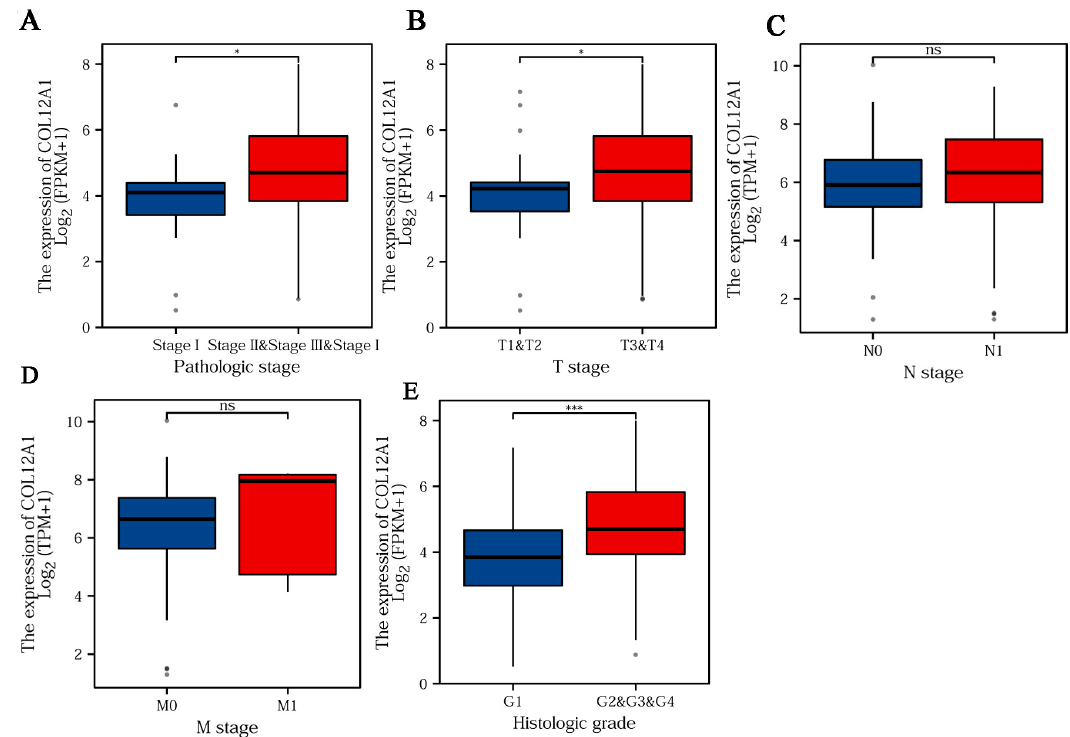
Figure 4. COL12A1 expression separated by different characters. ( A ) Pathological stages; ( B ) T stage; ( C ) N stage; ( D ) M stage; and ( E ) Histologic grade. *, p < 0.05, ***, p < 0.001, ns,